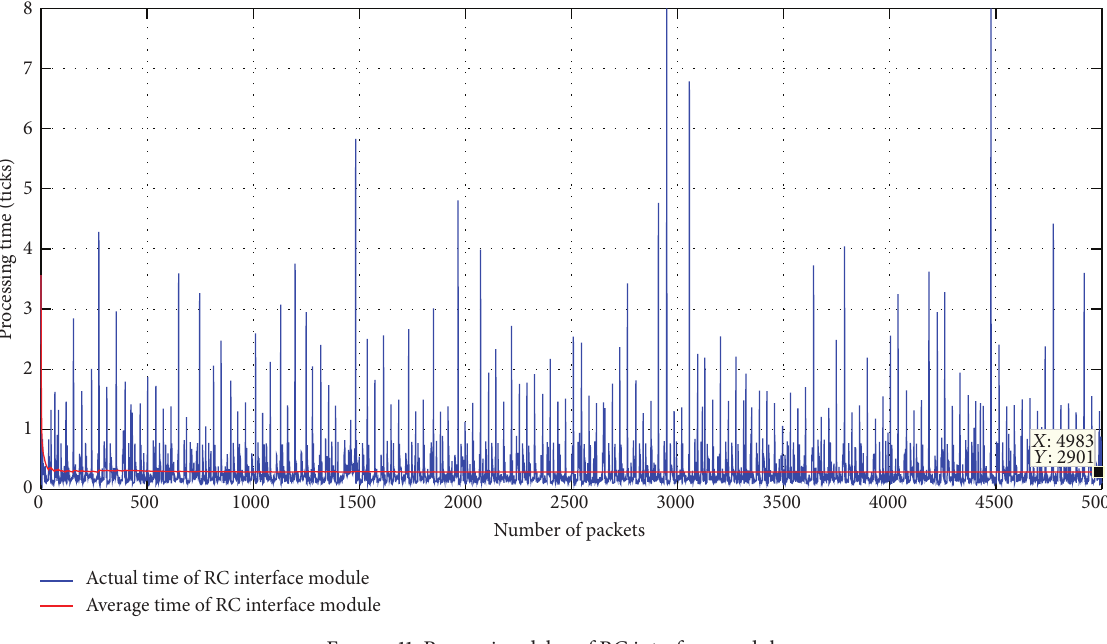
Figure 11: Processing delay of RC interface